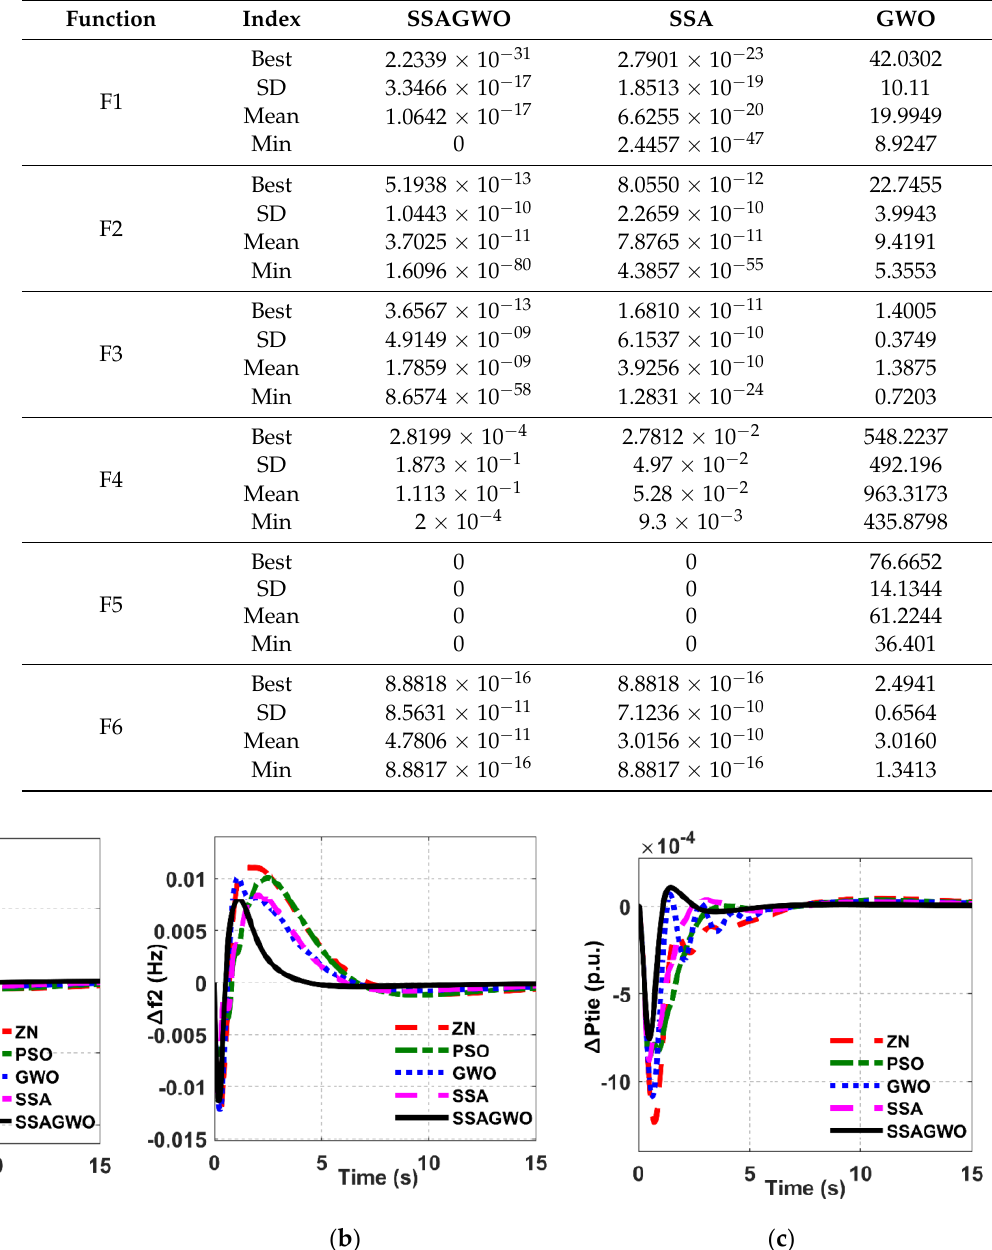
Table 3. Benchmark functions statistics.